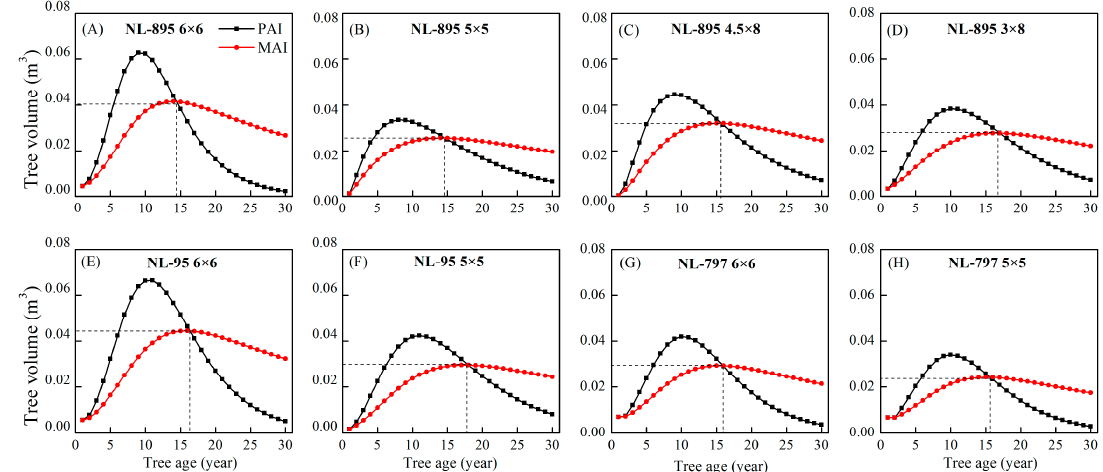
Figure 6. The mean annual increment (MAI) and periodic annual increment (PAI) of sample trees of four planting spacings of NL-895 ( A – D ) and two planting spacings of NL-95 ( E , F ) and NL-797 ( G , H ), which were calculated using Chapman–Richards model prediction data (up to 30 years).